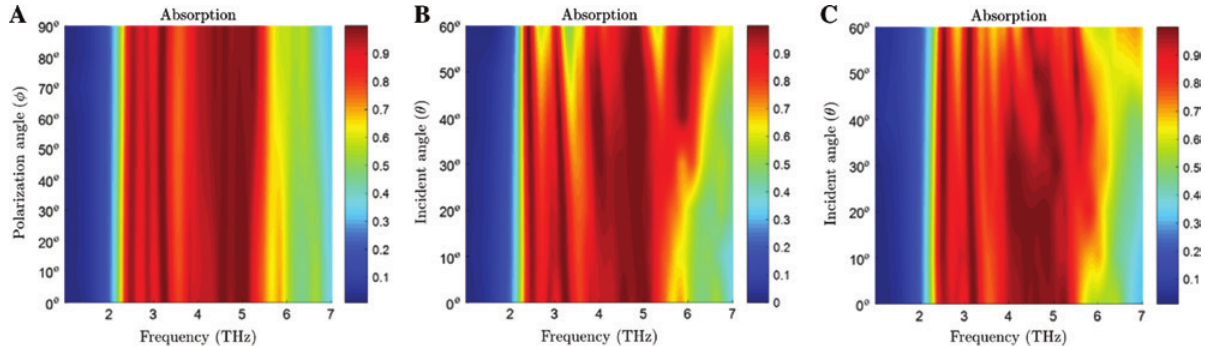
Figure 10: Numerically simulated angle-dependent absorption of broadband supercell design at thickness 11 μ m. (A) For different polarization angle ( ϕ = 0 ° –90 ° ). The polarization angle is rotating from TE polarization (0 ° ) to TM polarization (90 ° ). (B, C) For different incidence angle ( θ = 0 ° –60 ° ) for TE and TM modes,